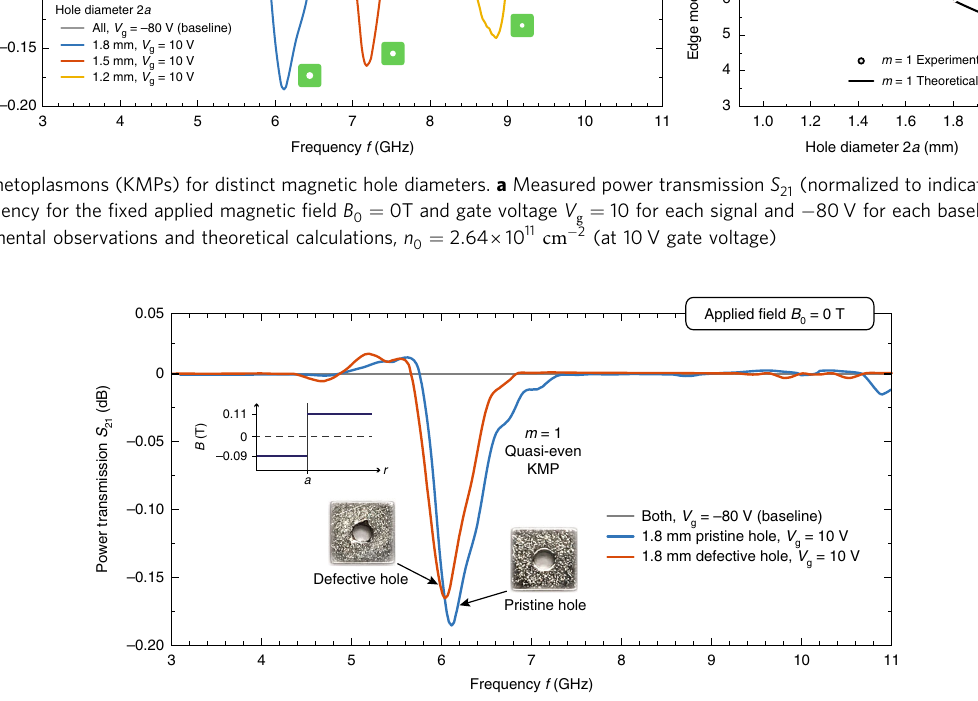
Fig. 10 Kink magnetoplasmons (KMPs) in magnetic domain with defects. Measured power transmission S 21 (normalized to indicated baselines) as a function of frequency for topological kink magnetoplasmons (KMPs) along defective and pristine magnetic domain